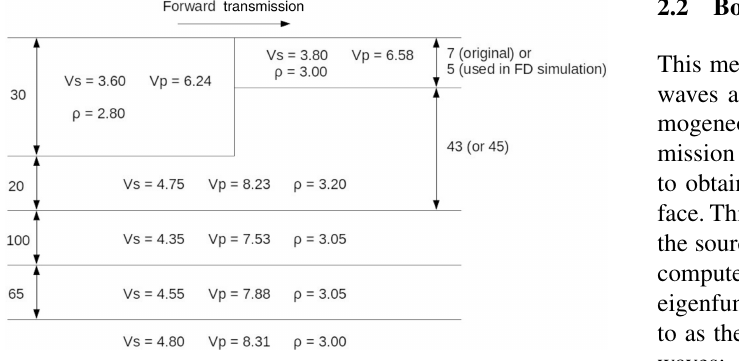
Figure 1. Schematic representation of “Model L”. Layer thick- nesses are shown in km and units for velocity and density are kms − 1 and gmcc − 1 respectively. Note that crustal thickness on the right-hand side was originally 7km but is modified to 5km for comparisons with finite-difference results in this study. The layer thickness of 5km facilitates the use of a 2 . 5km FD grid, keeping the numerical problem computationally tractable (a 7km thick layer would require a much finer FD grid spacing of